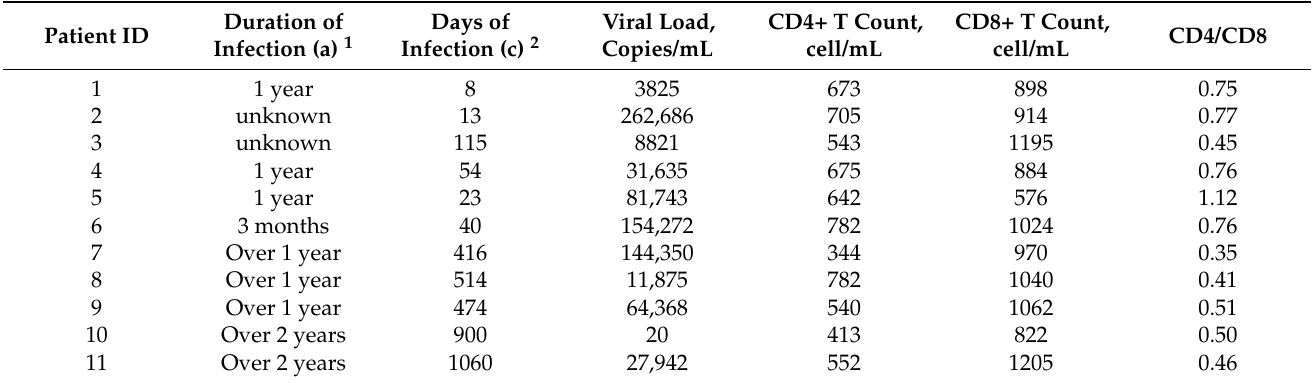
Table 1. The characteristics of patients enrolled in the study of gene expression estimated for peripheral blood mononuclear cells.